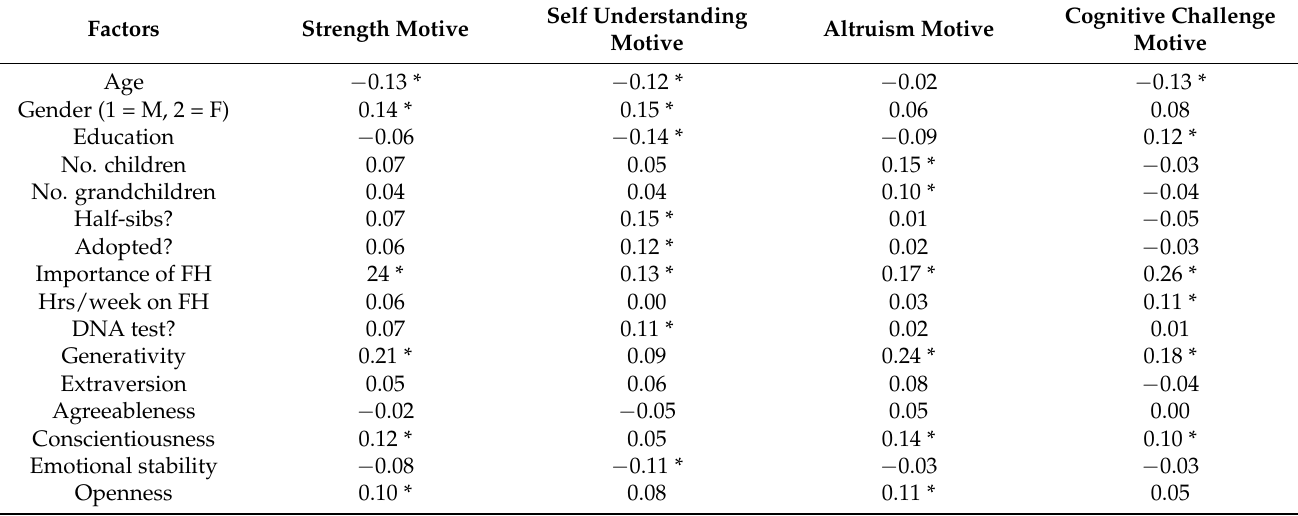
Table 4. Correlations between factors, demographic and personality